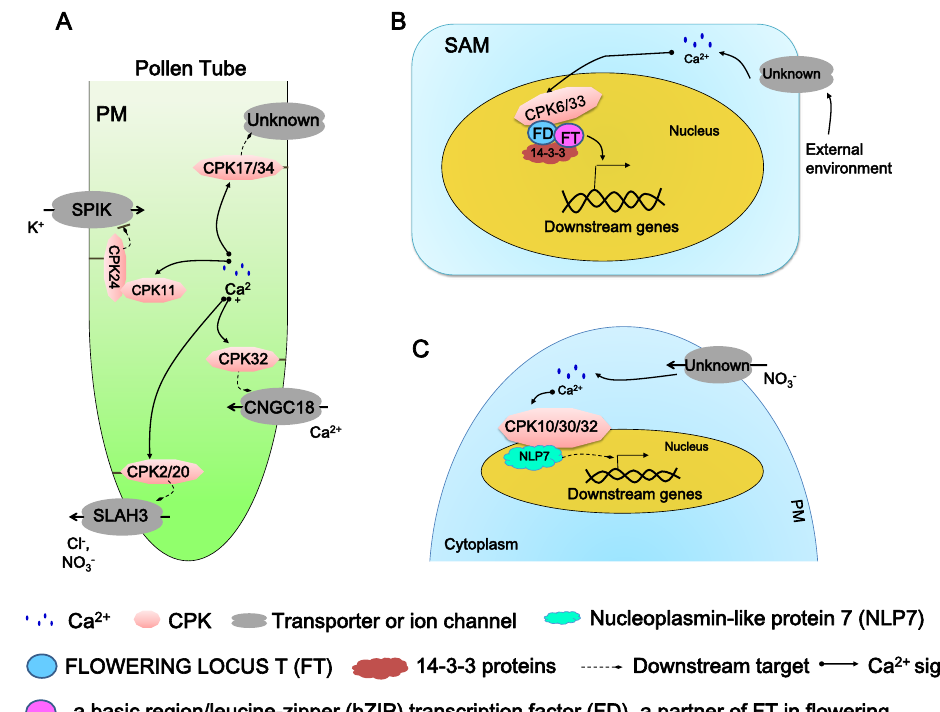
Figure 4. The function of AtCDPKs in the regulation of plant growth and development. The regulation networks of AtCDPKs in regulation of pollen tube elongation ( A ), floral signaling ( B ) and nutrition transport in plant cells ( C ). PM, plasma membrane. SAM, shoot apical meristem. External environment, photoperiod, light quality, and ambient temperature, as well as endogenous cues.